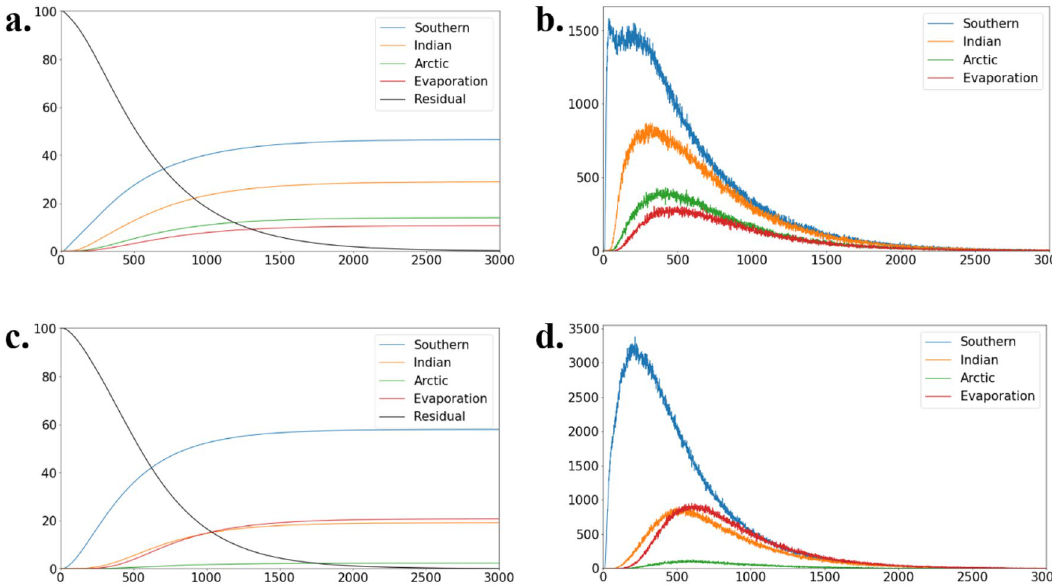
Figure 2. ( a ) The cumulative ratio (%) of the number of particles reaching each basin. ( b ) The number of particles reaching each basin in each year. ( c, d ) same as ( a, b ), but in the case 1D.